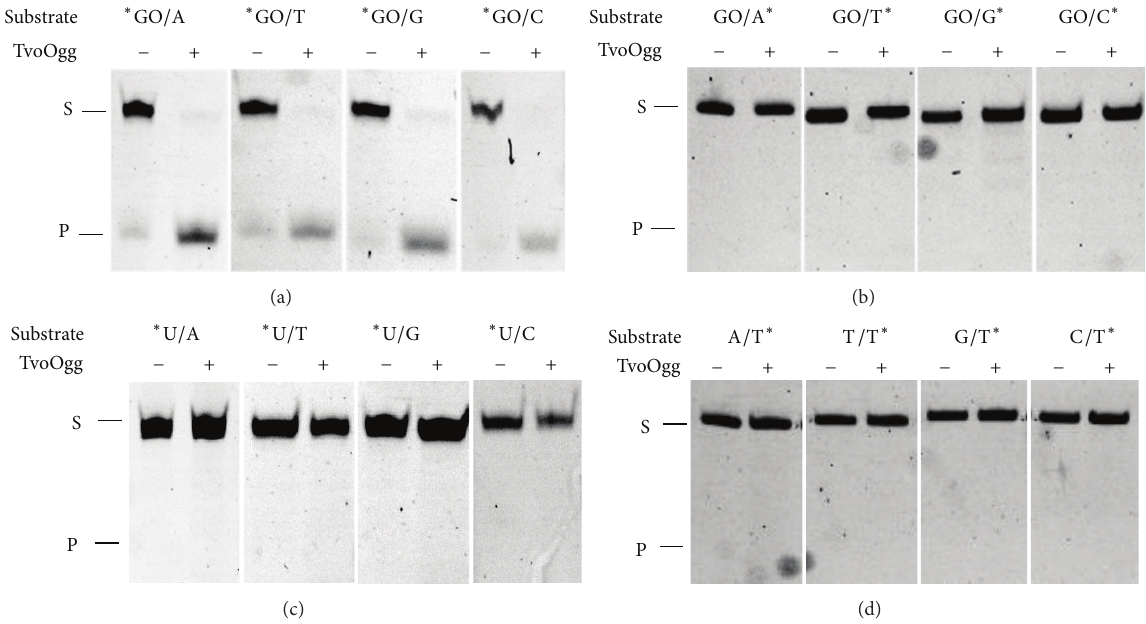
Figure 5: Requirement of GO for the substrates of TvoOgg. TvoOgg glycosylase/lyase activity was determined by analysis of the products in the presence (+) or absence ( − ) of 50 nM of TvoOgg on 34-bp double-stranded DNA containing (a) ∗ GO / N, (b) GO / N ∗ , (c) ∗ U / N, or (d) A / N ∗ (N means A, T, G, or C). The uncut 34-mer DNA substrates (S) and cleaved 13-mer products (P) are indicated on the left. Asterisks indicate 5 󸀠 -FAM-labeled